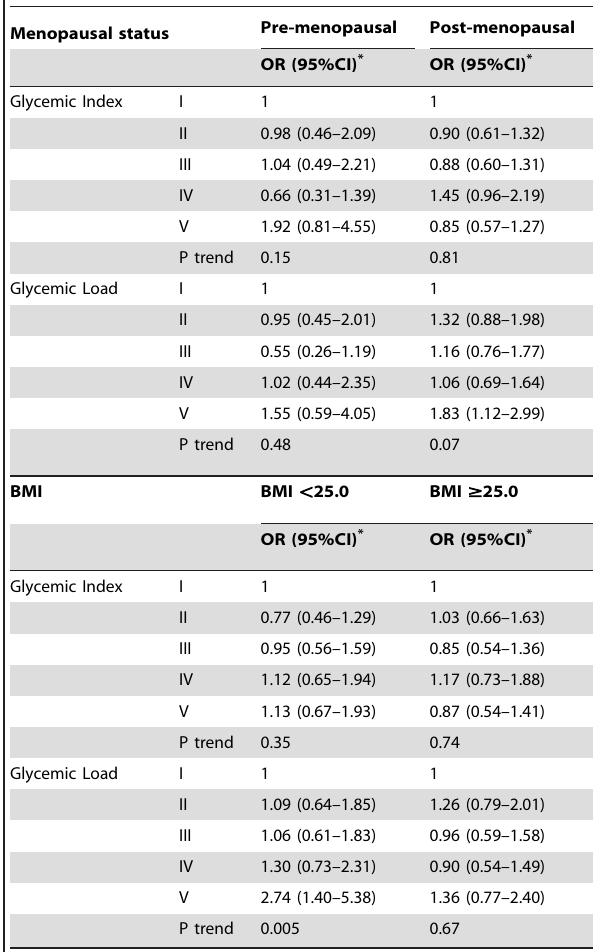
Table 5. Association between energy-adjusted GI and GL and high MBD by menopausal status and BMI (1,628 EPIC-Florence